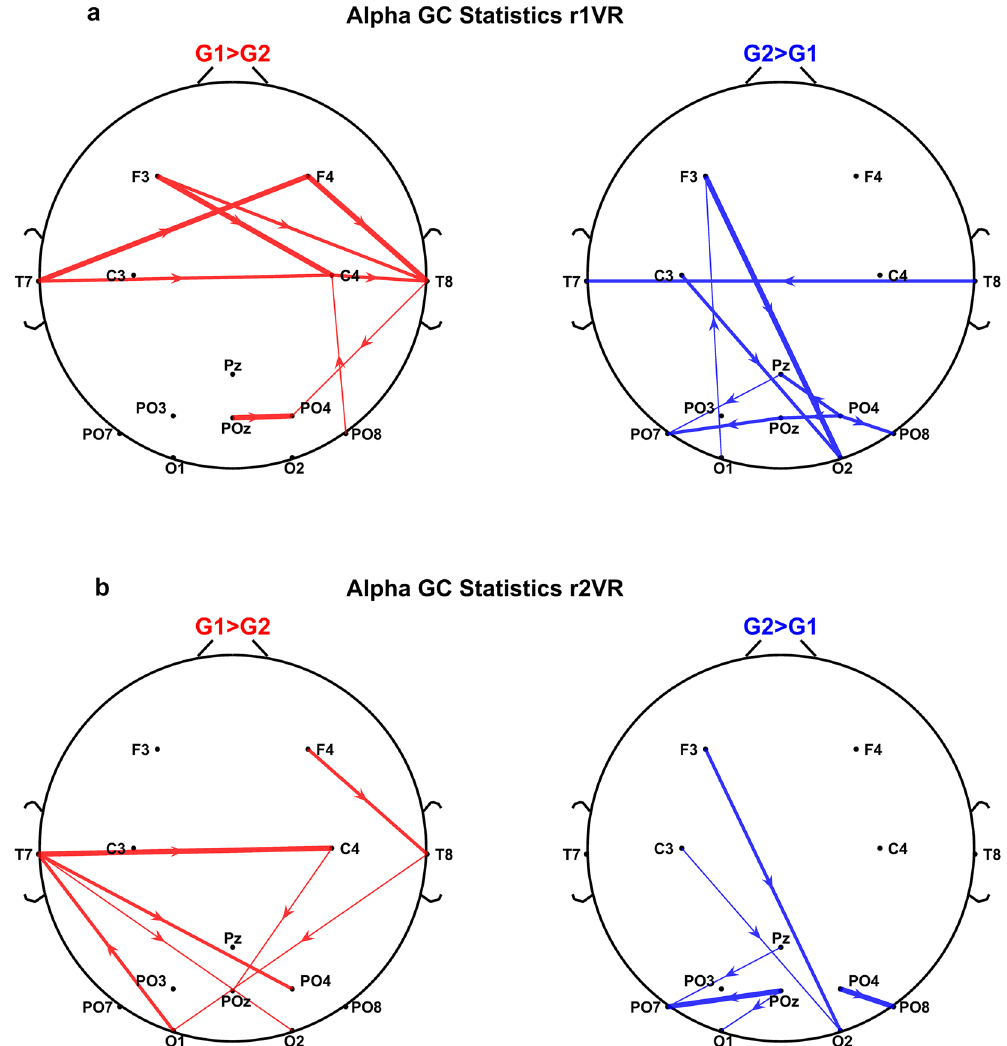
lines refer to normalized connections higher in group G1, whereas blue lines denote normalized connections higher in G2, in each VR-immersion phase (r1VR: top panel, r2VR_bottom panel). The displayed arrows correspond to significant connectivity changes at p-value < 0.05 (uncorrected one-tailed permutation-based t test) and the thickness of the line denotes three levels of significance, i.e., thinnest line: 0.025 ≤ p < 0.05 ; middle line: 0.01 ≤ p < 0.025 ; thickest line: p < 0.01